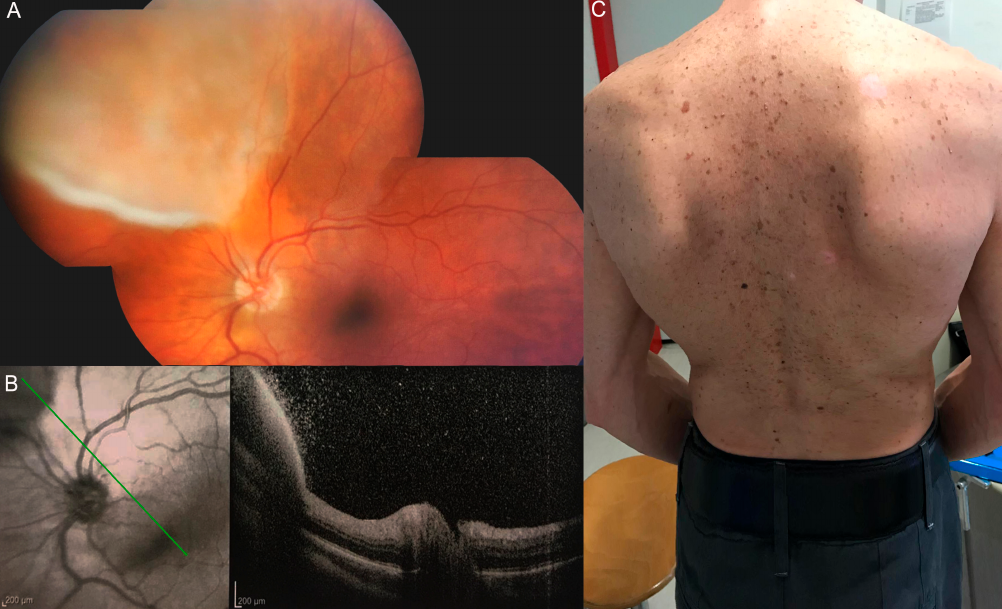
Figure 1. Presentation of syphilis. Fundus examination ( A ) shows the presence of vitreous inflammation and multiple superficial pre-retinal aggregates are evidenced on optical coherence tomography (OCT) scans ( B ). The patient presented a form of tertiary syphilis affecting both the eye ( A,B ) and the skin ( C ).